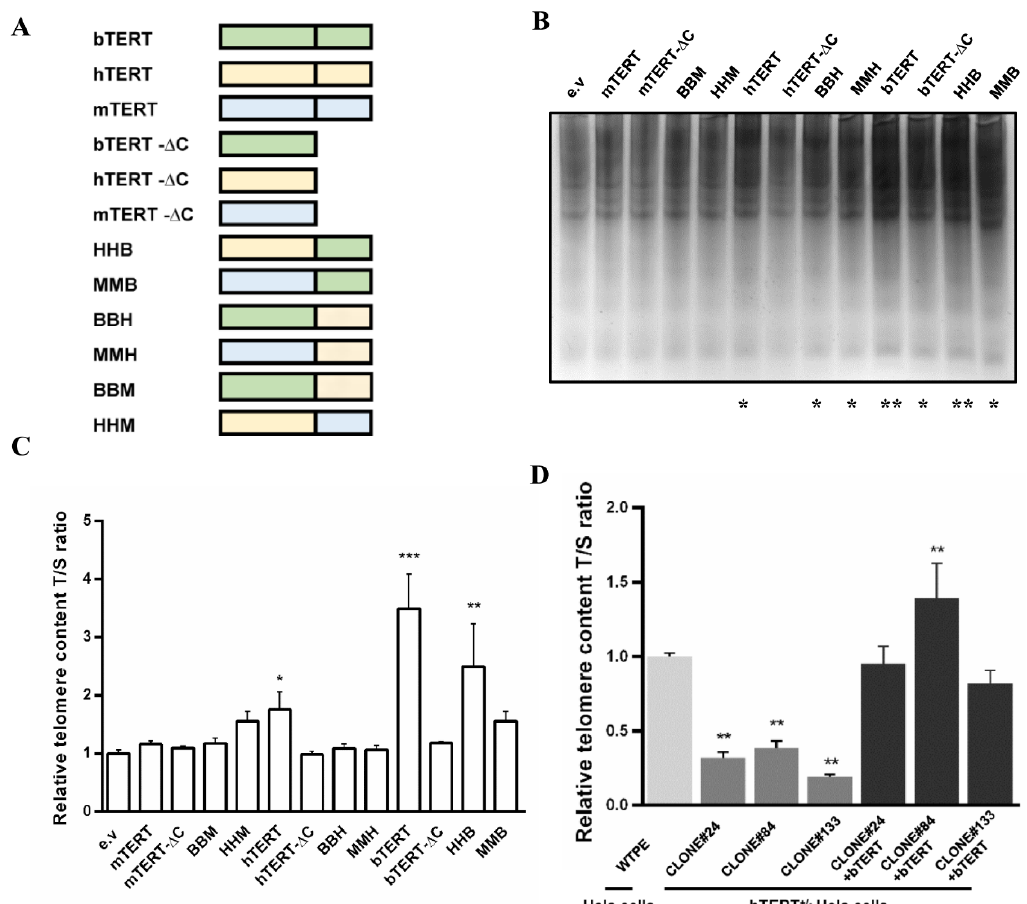
Figure 1. b TERT is a potent factor for immortalization. ( A ) Diagram of expression vectors of TERT s. TERTs ₋ −∆ C represent truncated expression vectors without CTD domain. HHB, MMB, BBH, MMH, BBM, and HHM represent the substitute recombinant expression vectors with CTD replacement of TERTs of different species. Green is for bovine TERT, yellow is for human TERT, and blue is for mouse TERT. ( B ) TRAP analysis of BFFs transfected with TERT s, TERTs ₋ −∆ C, substitute recombinant TERT s or empty vector. e.v, empty vector. ( C ) Relative telomere length of BFFs transfected with TERT s. TERTs ₋ −∆ C, substitute recombinant TERT s or empty vector, respectively. Bovine β ₋ globin served as internal reference. e.v., empty vector. ( D ) Relative telomere length of WTPE, three h TERT +/ − colonies of Hela cells (CLONE#24, CLONE#84, and CLONE#133), and three h TERT +/ − colonies resupplied with bTERT. “WTPE” represents wild ₋ type Hela cells. Human β ₋ globin served as internal reference. Data in B ₋ D were mean ± s.d., n = 3 independent experiments, one ₋ tailed Student’s t ₋ test. * p < 0.05, ** p < 0.01, *** p < 0.001 vs. e.v or WTPE.